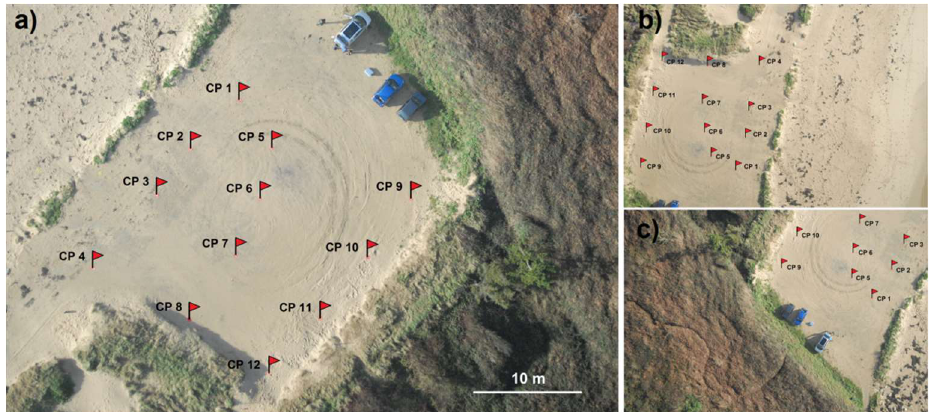
Figure 4. Examples of photographs collected by DRELIO 5 in February 2009 above the grid pattern of targets for camera calibration.